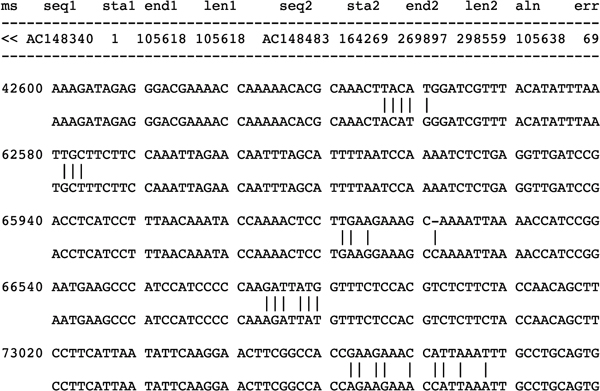
Alignment output of ClustDB. The BAC AC148340 (len1 = 105618 bp) is approximately contained in the BAC AC148483 (len2 = 298559 bp). The alignment has length aln = 105638 including 20 gaps in AC148340 and 9 gaps in AC148483. Its displayed part shows five clusters of mismatches surrounded by long perfect matches so that the number of errors does not exceed 10 in each window of size 40. Therefore, ClustDB does not look for improvements by introducing gaps and reports 69 errors, i.e. 16 errors more than the exact alignment computes. Note that each cluster of mismatches can be realigned with two gaps.